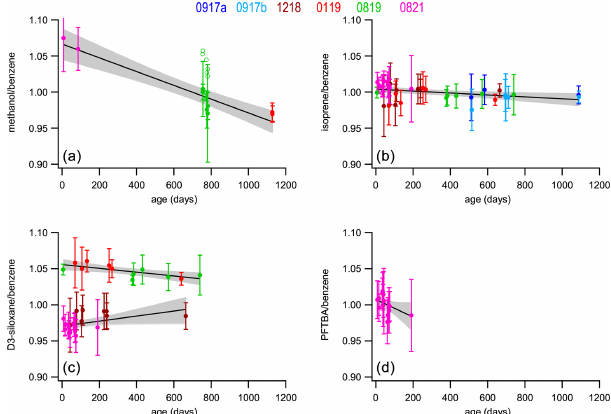
Figure 3. Stability of the normalized response with time for four selected compounds relative to benzene, methanol (a) , isoprene (b) , D3-siloxane (c) , and PFTBA (d) for all six PRMs (solid symbols). The open symbols (methanol; top left) show the original data before being corrected for an observed 5.0% bias in the parent mixture (A410). The best-fit curves from least-squares straight-line regres- sion analyses are shown (solid black line) along with the 95% con- fidence interval of the fits (shaded area). The slope, intercept, and F-statistic data from the regression analyses are shown in Table 3. Stability plots for all the compounds are shown in Fig. S1.